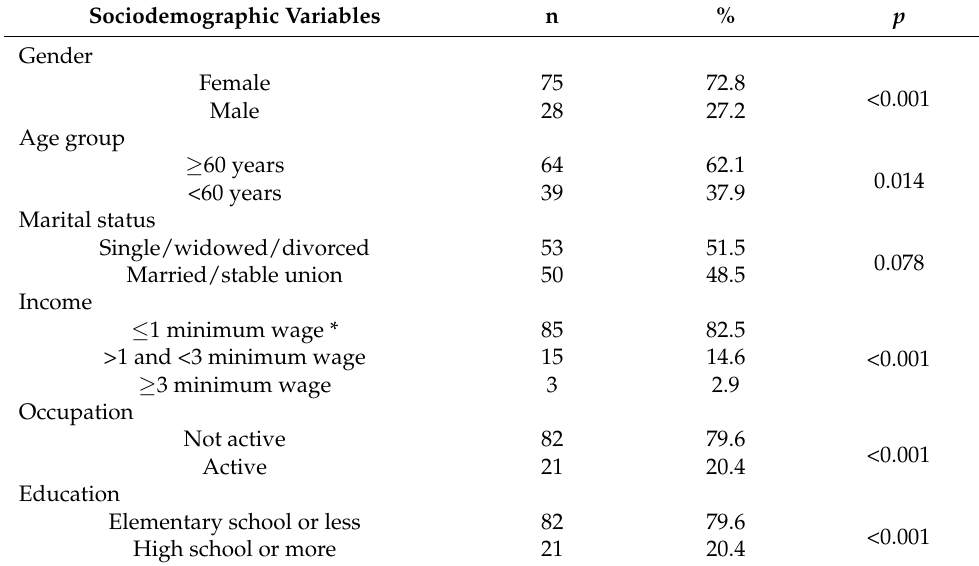
Table 1. Sociodemographic characterization of